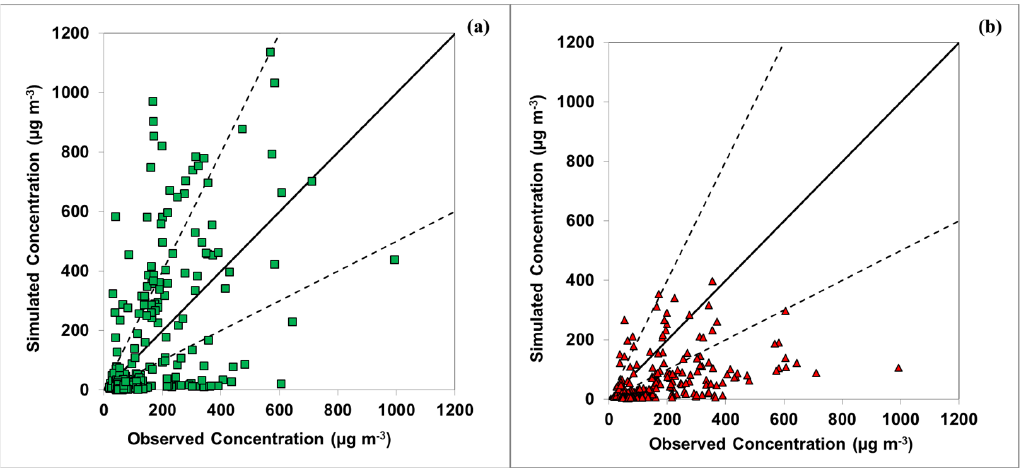
Figure 2. Hourly scatter plot of simulated PM 10 concentrations with ( a ) MOSAIC aerosol module and ( b ) MADE/SORGAM aerosol module against observed PM 10 levels over Delhi.